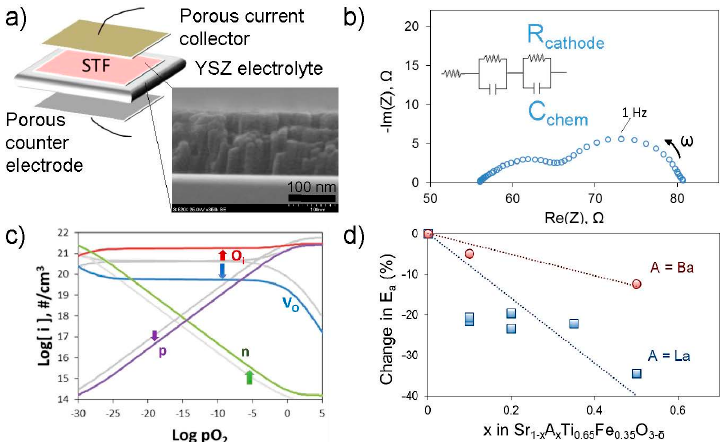
Figure 5. Overview of use of model thin film electrodes with controlled geometries for study of impact of bulk defect chemistry on surface exchange kinetics. ( a ) Schematic of asymmetric cell used for electrochemical impedance measurements of k q for thin film (Sr,A)(Ti,Fe)O 3 −δ electrodes; ( b ) Example impedance spectrum of cell in ( a ) showing equivalent circuit; ( c ) Calculated change in point defect concentrations at 873 K upon La doping, [La] = 0.2 in color vs. [La] = 0 in grey, using model in [34] by Perry et al.; ( d ) Change in activation energy for surface exchange coefficient k q for various doping levels; Ba data from [50] by Kim et al. and La data from Perry (unpublished).